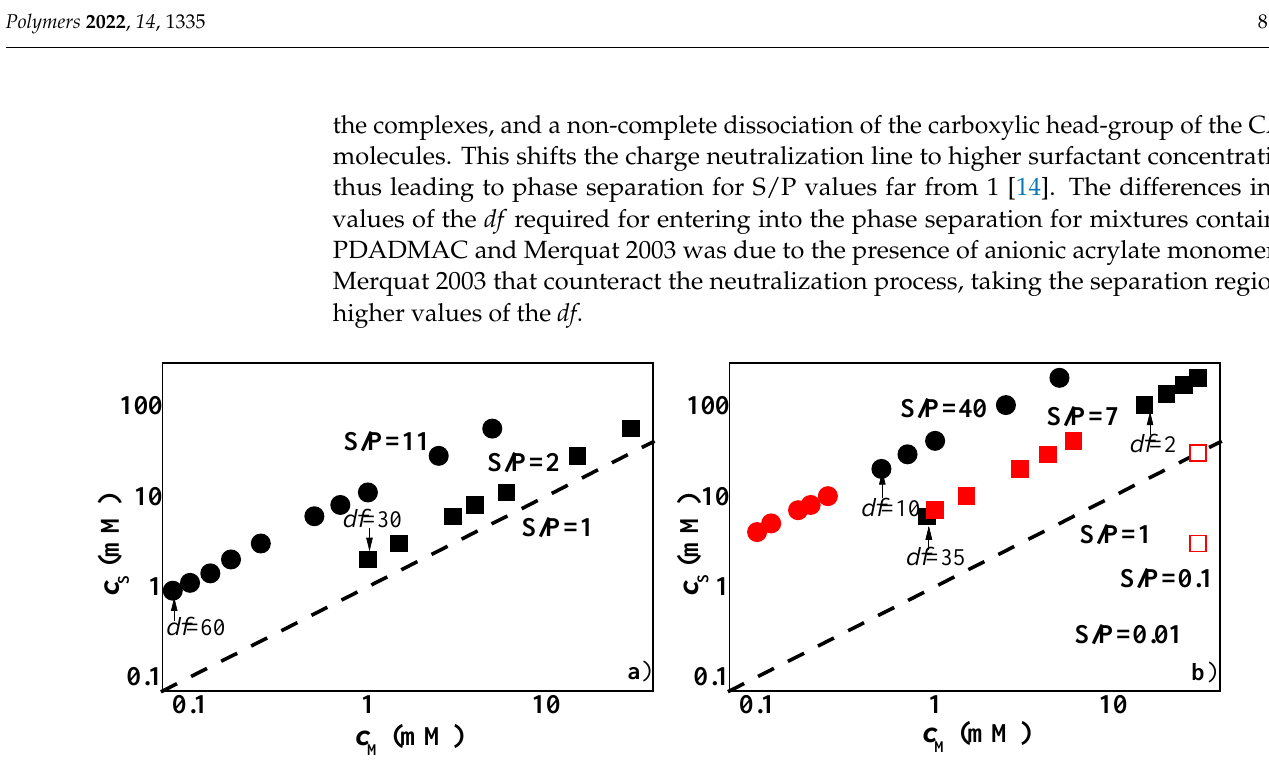
Figure 3. Surfactant ( c S )–polymer ( c M ) concentration phase diagrams for the combination of PDADMAC ( ■ and ■ ) or Merquat 2003 (● and ● ) with LE12 ( a ) and CAPB (Notice that □ corresponds to phase-separated mixtures obtained by mixing a fixed PDADMAC concentration and increasing CAPB concentrations) ( b ). The black and red symbols correspond to one-phase and phase-separated mixtures, respectively, and the discontinuous solid line corresponds to the dilution of a hypothetical mixture with S/P = 1. The values of the dilution factors ( df ) corresponding to the onset and exit of the phase-separation region, or the maximum df explored for samples in which only phase was found are also indicated. Furthermore, the S/P values corresponding to the dilution line of each sample are also included. Notice that the data for Merquat 2003 only considers the concentration of cationic monomers.